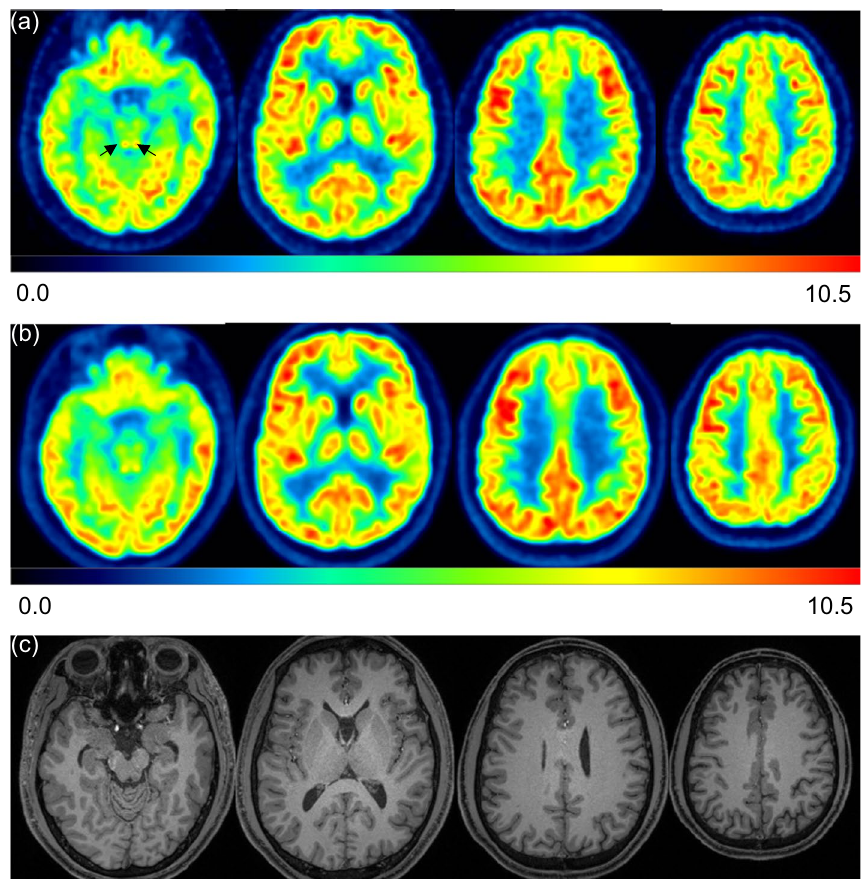
Fig. 2 Representative images of FDG of the brain using Vrain ( a ) and whole-body PET ( b ). Axial images from the left are at the level of the inferior colliculus (arrows), basal ganglia, centrum semi-ovale, and fronto-parietal area. All PET images were co-registered to T1WI MRI ( c ). The SUV is indicated by the